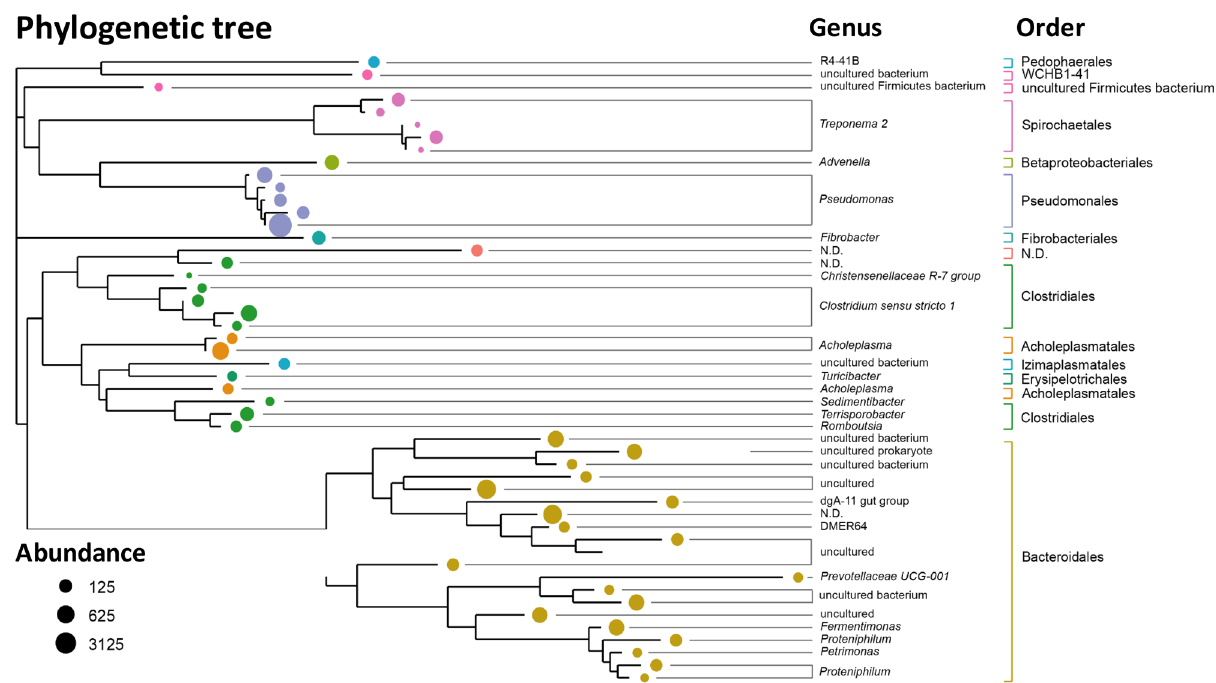
Figure 6. Phylogenetic tree of the most abundant bacteria presents in the R2